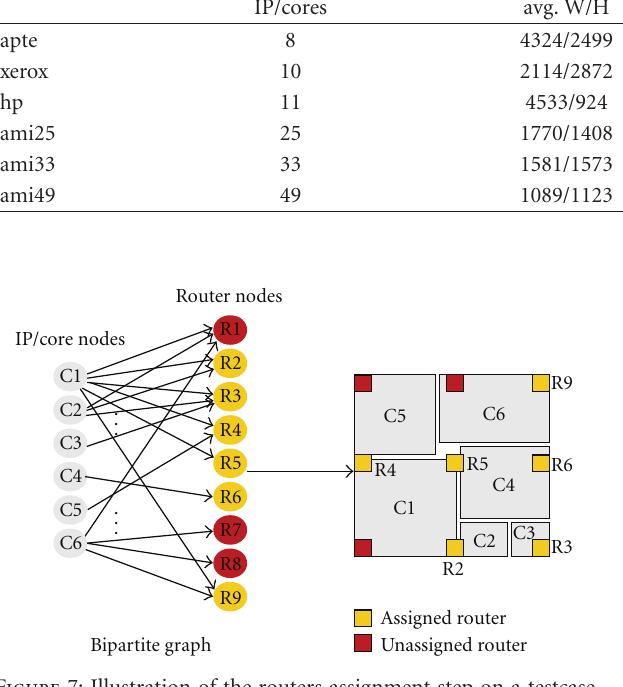
Figure 7: Illustration of the routers assignment step on a testcase with 6 IP/cores and a regular mesh network of 3 × 3